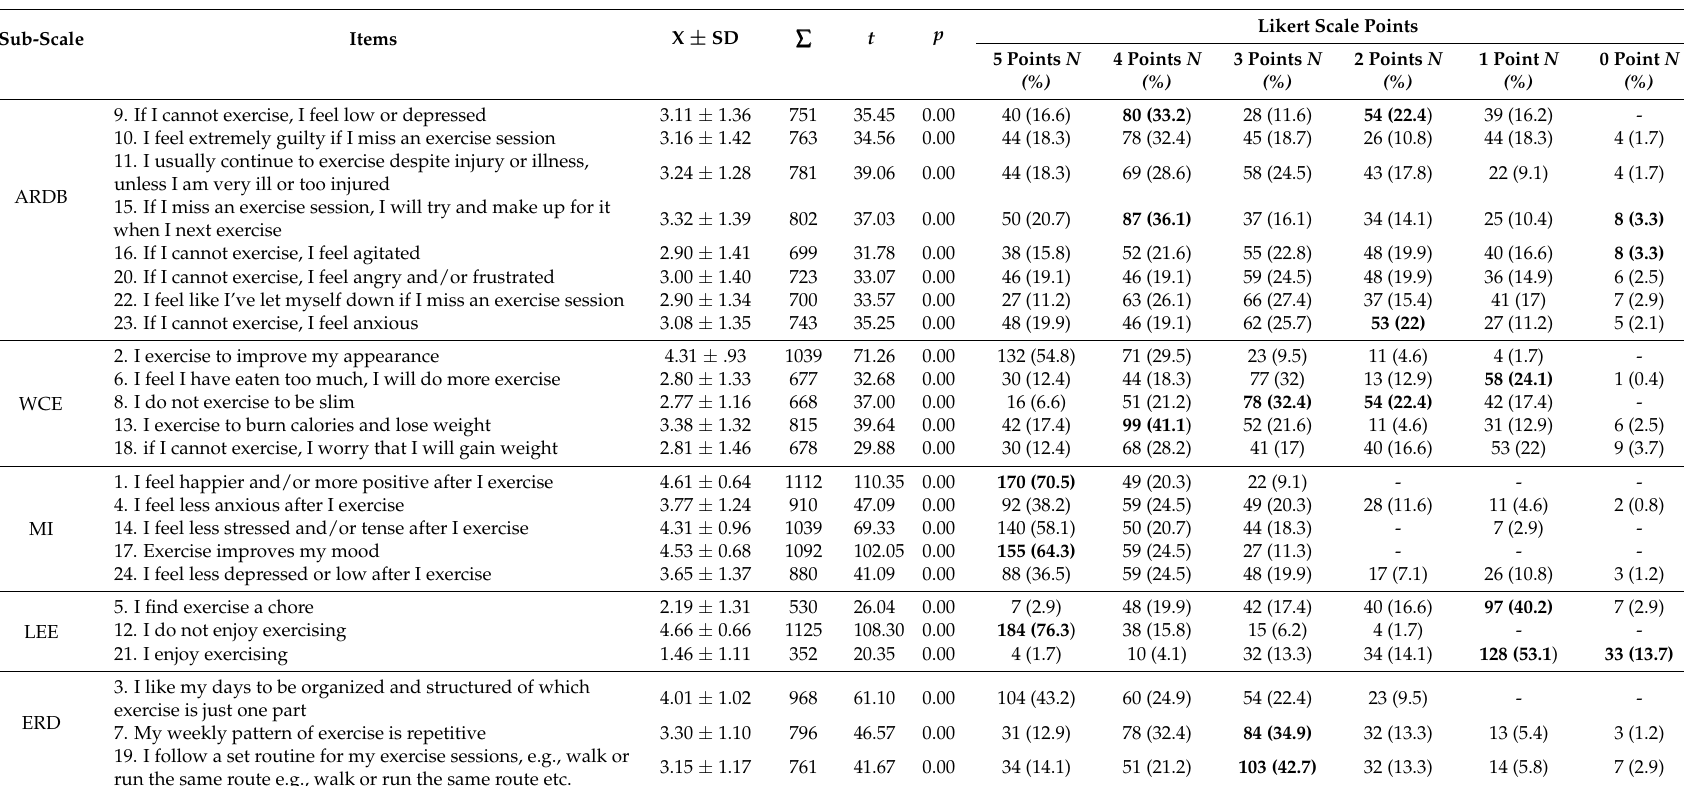
Table 2. The statistical analysis of the average responses according to the Likert scale (6) per item in the questionnaire evaluating the Compulsive Exercise Test (CET).